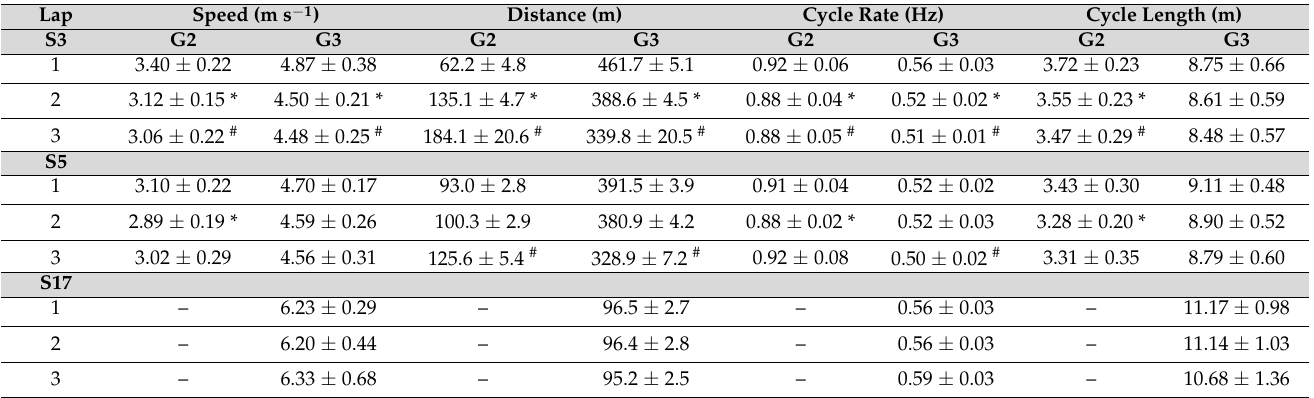
Table 3. Speed, distance, and kinematics in the G2 and G3 sub-technique in two selected uphill sections (S3 and S5) and the flat section (S17) per lap during a 10 km skating time-trial in fourteen national-level male cross-country skiers.